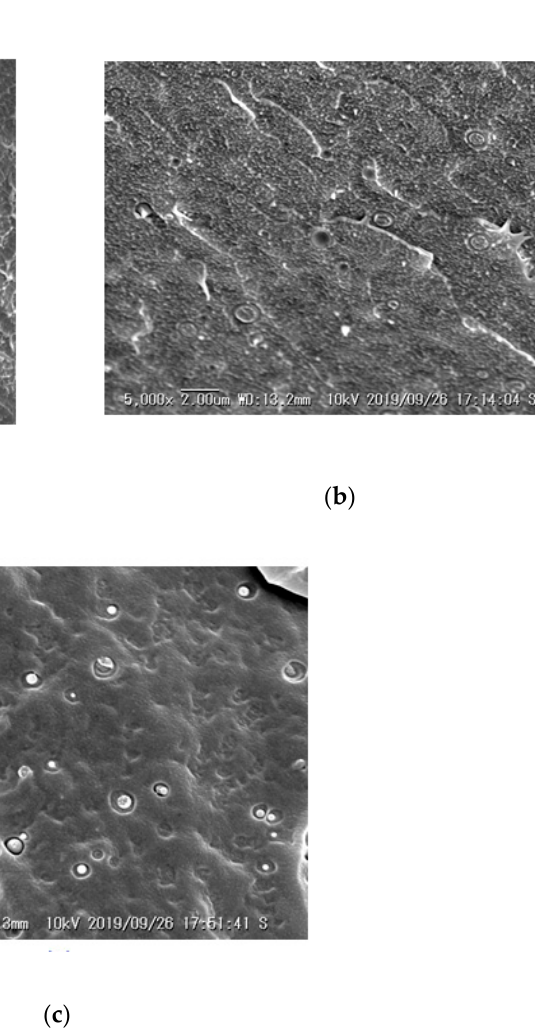
Figure 5. SEM images of cross sections for cryogenically fractured samples: ( a ) LDPE; ( b ) LDPE/PS; ( c ) XLPE-PS 3#. As for LDPE/PS and XLPE-PS 3#, differences in the matrix and PS particles could be